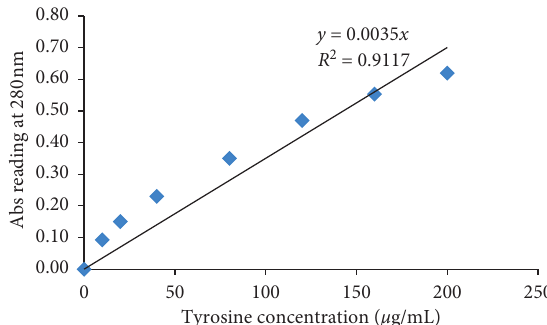
Figure 1: Tyrosine standard curve for acid protease